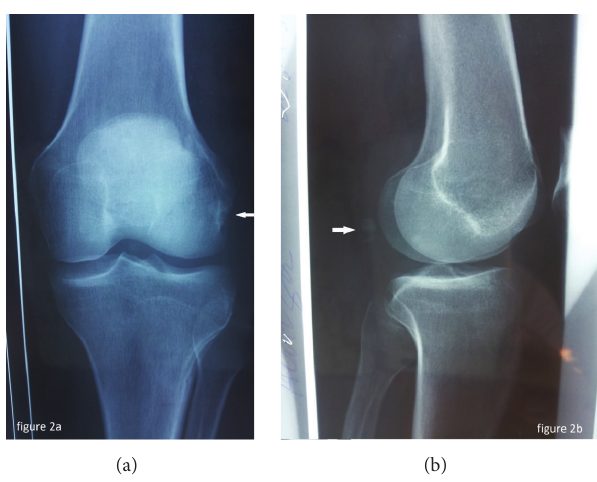
Figure 2: Anteroposterior (a) and lateral (b) plain films of the left knee showing a fabellar fracture.